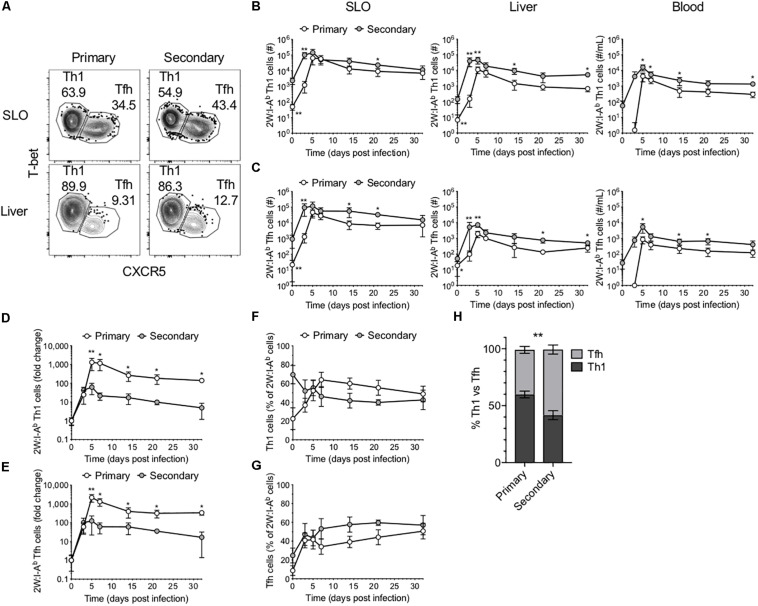
Comparison of Th1 and Tfh responses in primary and secondary Lm infection. (A) Phenotype of 2W:I-Ab-specific CD4+ T cells in the SLOs and liver at 5 dpi following primary or secondary Lm infection after excluding Foxp3+ Tregs. Number of 2W:I-Ab-specific T-bet+ Th1 cells (B) and CXCR5+ Tfh cells (C) in the SLOs, liver and blood. Fold change of 2W:I-Ab-specific Th1 (D) or Tfh (E) cell expansion during primary versus secondary Lm infection. Frequency of 2W:I-Ab-specific T-bet+ Th1 cells (F) or CXCR5+ Tfh cells (G) in SLOs. (H) Frequency of 2W:I-Ab-specific Th1 versus Tfh cells in SLOs at 14 dpi. Data are compiled from two to three independent experiments per time point with n = 1–4 mice per experiment. *P < 0.05, **P < 0.01 as determined by two-way ANOVA followed by Sidak’s multiple comparison test (H) or Mann Whitney U test (B–G). Bars represent mean ± SD.